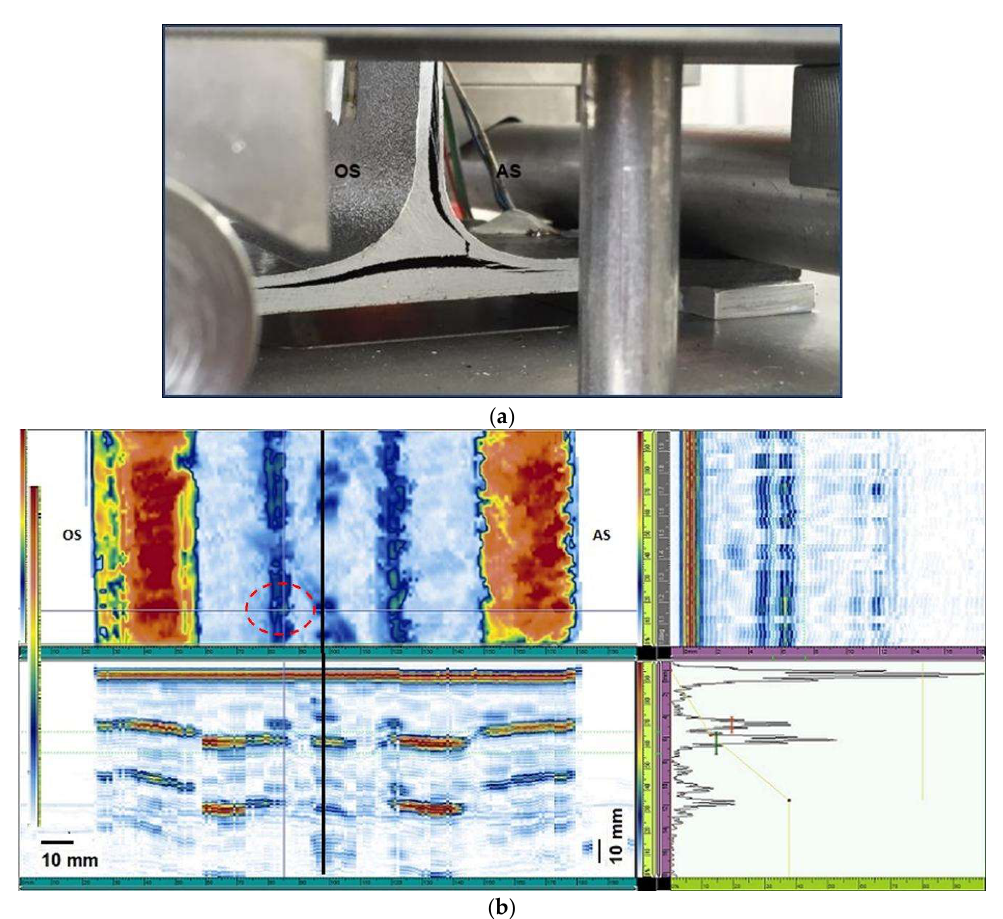
Figure 10. ( a ) Specimen 4 after delamination fracture; ( b ) UT images before the breaking; the red circle shows an irregular defected area.